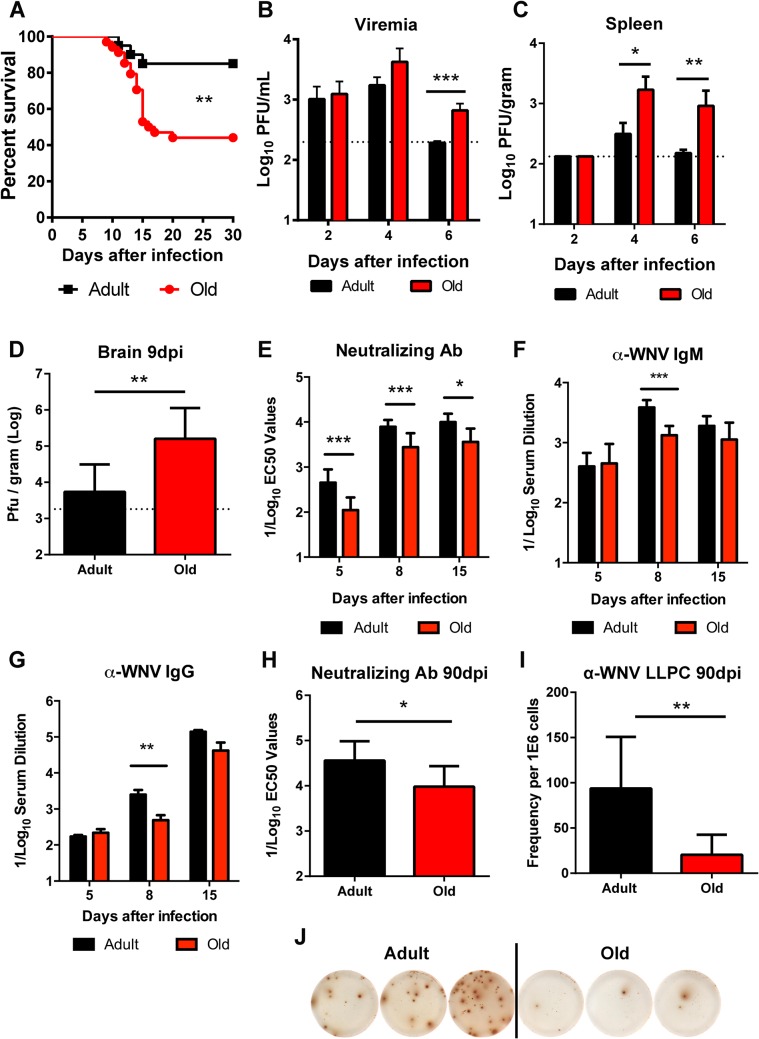
Survival rate, viral burden, and B cell responses after WNV infection.
A. Adult or old mice were infected with 102 PFU of WNV (New York strain) via subcutaneous injection in the footpad. Survival was monitored for 30 days: n = 20 adult (16 weeks) and n = 34 old (18 months) mice from at least three independent experiments. The difference was statistically different (P < 0.01; log rank test). B-D. Viral burden after WNV infection of adult and old mice was measured by qRT-PCR from serum (B) and plaque assay from spleen and brain (C-D). The data is shown as the mean titer (log10 PFU/ml) ± standard deviation (SD) and reflects 8 to 9 mice per time point from at least two independent experiments. The dashed lines represent the limit of sensitivity of the assay. Asterisks indicate statistical significance (*, P < 0.05; **, P < 0.01; ***, P < 0.001; Mann-Whitney test). E-H. Serum was obtained from adult and old mice at days 5, 8, 15, and 90 after WNV infection. E and H. Neutralizing antibody titers were determined by a focus-reduction assay. Results are shown as the mean of the reciprocal log10 titer ± SD that yields 50% inhibition of infection and reflects data from 5 to 11 mice per group from three independent experiments. F-G. Anti-WNV IgM (F) and IgG (G) levels were measured by ELISA. Data is plotted as the reciprocal log10 titer, defined as three times greater than background. I-J. Ninety days after infection, WNV-specific antibody secreting long-lived plasma cells in the bone marrow (LLPC) were quantified. Shown is the LLPC frequency per 106 bone marrow cells ± SD (I), as well as representative ELISPOT images from three adult and three old mice (J). Data is pooled from 6 to 9 mice per group from three independent experiments.